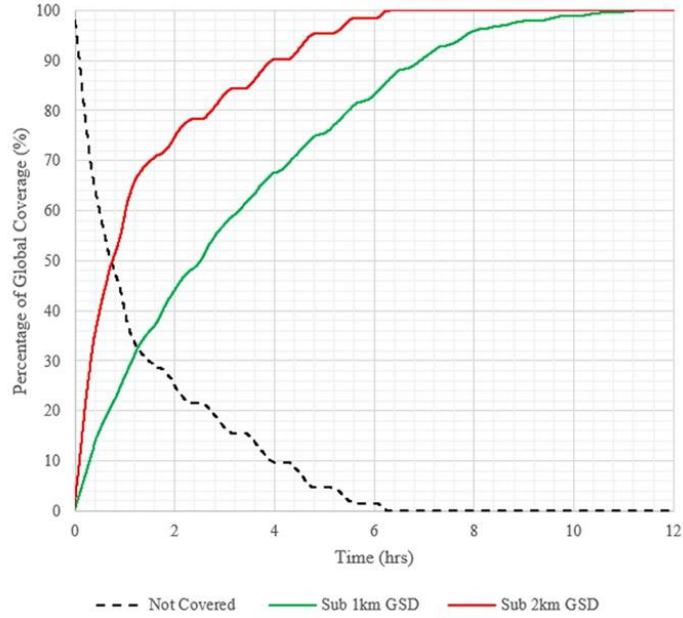
Figure 7. Cumulative global coverage from combined LEO instruments. Incorporating GEO views allows for a large percentage of the globe to be continuously viewed and updated every 10 min. “The Wall” combines imagery from GOES-16 (75.2 ◦ W), Meteosat-11 (0 ◦ E), and Himawari-8 (140.7 ◦ E), this is extended to also include GOES-17 (137.2 ◦ W) and Meteosat-8 (42.0 ◦ E) in simulations to provide good coverage of the ± 60 ◦ latitude band (see Figure 8) at which point the imagers are limited due to disk edge distortion with each view achieving 1 km